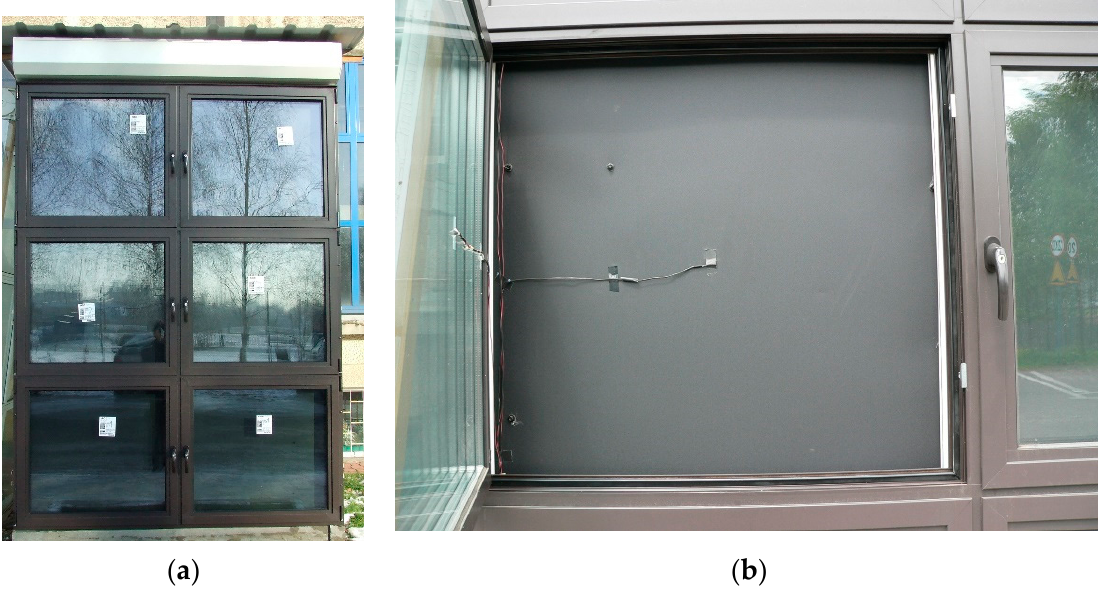
Figure 6. View of the tested wall: ( a ) in its entirety after installation of glazing; ( b ) single segment after opening and mounting of the temperature sensors.